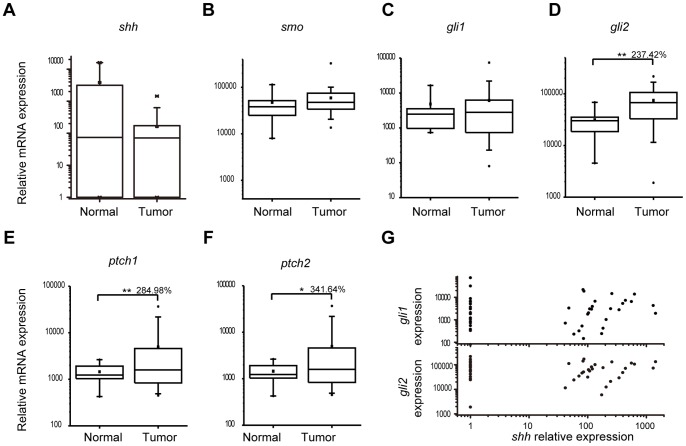
RNA Expression of Gli and SHh Pathway Components in MPM. A–F, Statistic analysis of shh, smo, gli1, gli2, ptch1 and patch2 mRNA expression in normal pleura and tumor tissues. A total of 46 tumor tissues was compared with 7 patient normal pleura for its relative mRNA levels of shh, smo, gli1, gli2, ptch1, ptch2 by quantitative RT-PCR. Two-sided student’s t-test was performed between normal and tumor tissues. gli2, ptch1 and ptch2 showed significant elevation (D–F). A p value <0.05 was indicated as *, <0.01 as **, and <0.001 as ***. The average expression of tumor tissues was labeled in the three genes with the average of normal pleura as 100% (D–F). G, Correlation analysis between shh and gli1 (upper) and gli2 (lower). The expression of shh was undetectable in 43% of samples, and thereby shown as the baseline level.